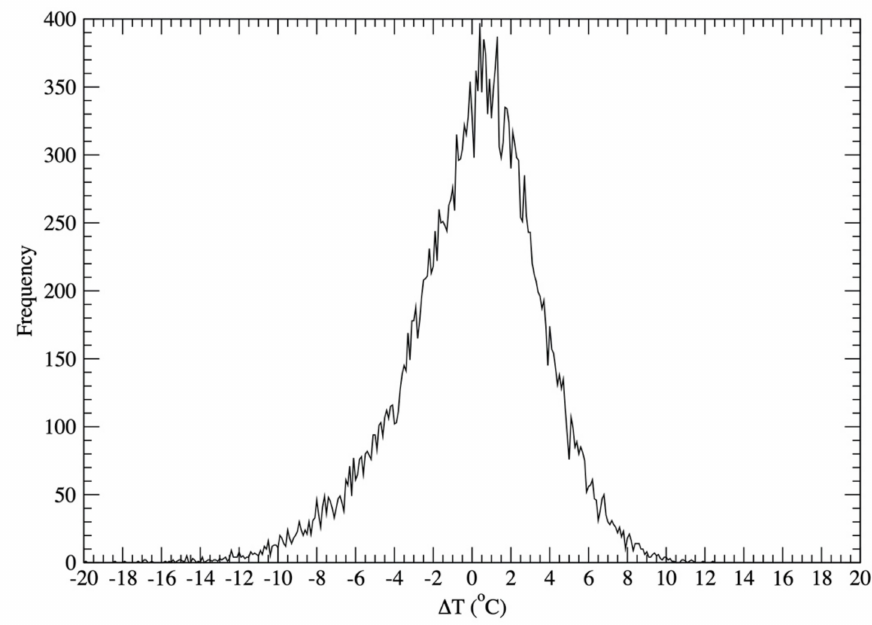
Figure 4. Probability distribution of ∆